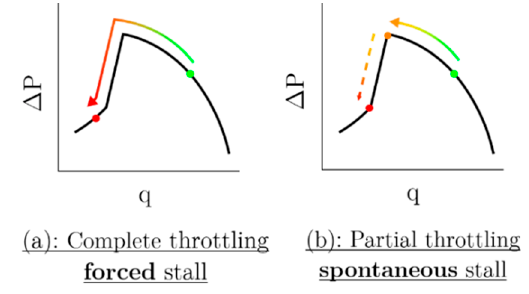
Figure4. Schematicrepresentationofthethrottlingprocess.( a )Completethrottling; ( b Figure 4. Schematic representation of the throttling process. ( a ) Complete throttling; ( b ) partial throttling.